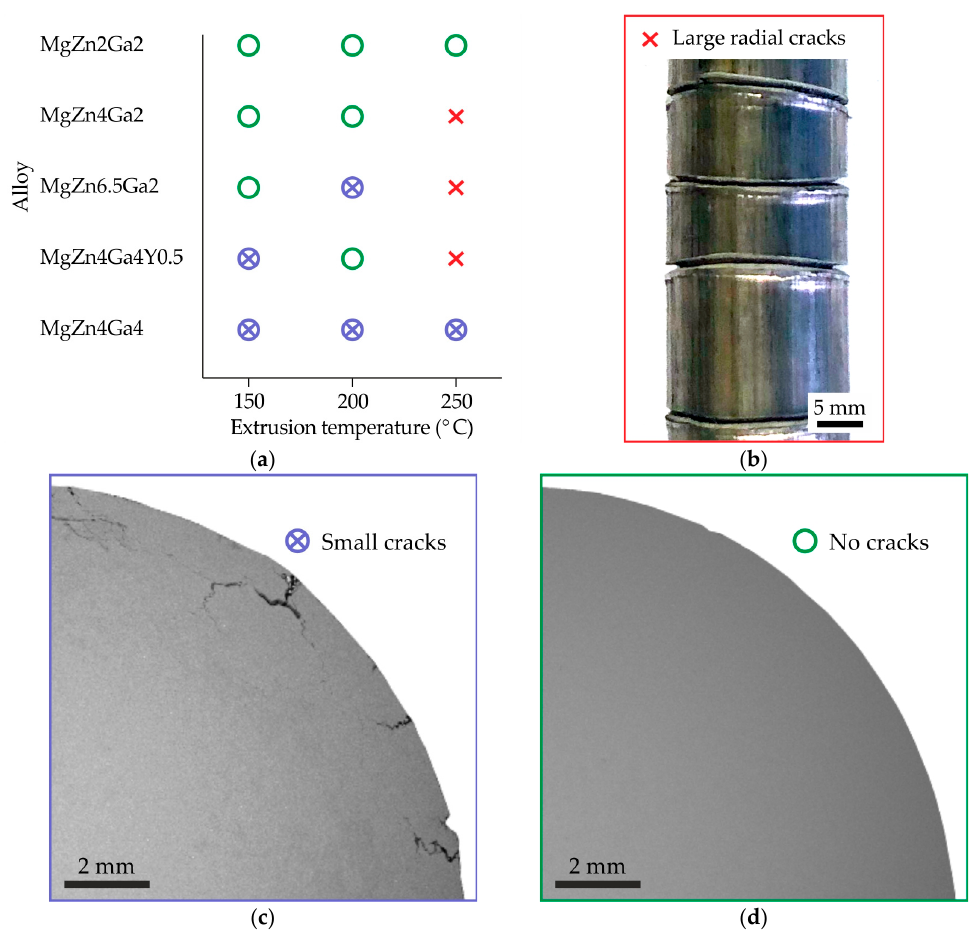
Figure 2. ( a ) Graph defining the quality of the Mg–Zn–Ga–(Y) alloy bars as a function of alloy composition and extrusion temperature. The quality examples are shown in: ( b ) bar with large radial cracks (e.g., MgZn4Ga2 alloy extruded at 250 °C), ( c ) bar with small (~1 − 2 mm) surface cracks (e.g., MgZn4Ga4 alloy extruded at 150 °C), and ( d ) bar without cracks (e.g., MgZn2Ga2 alloy extruded at 150 °C).